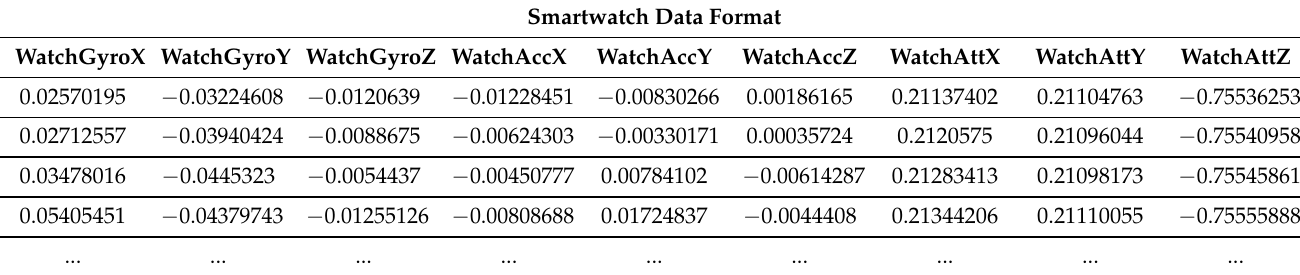
Table 3. Smartwatch in-air signature data format.